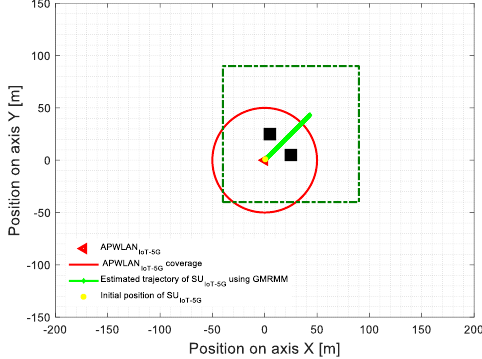
Figure 2 . Estimated trajectory of SU IoT-5G using GMRMM.